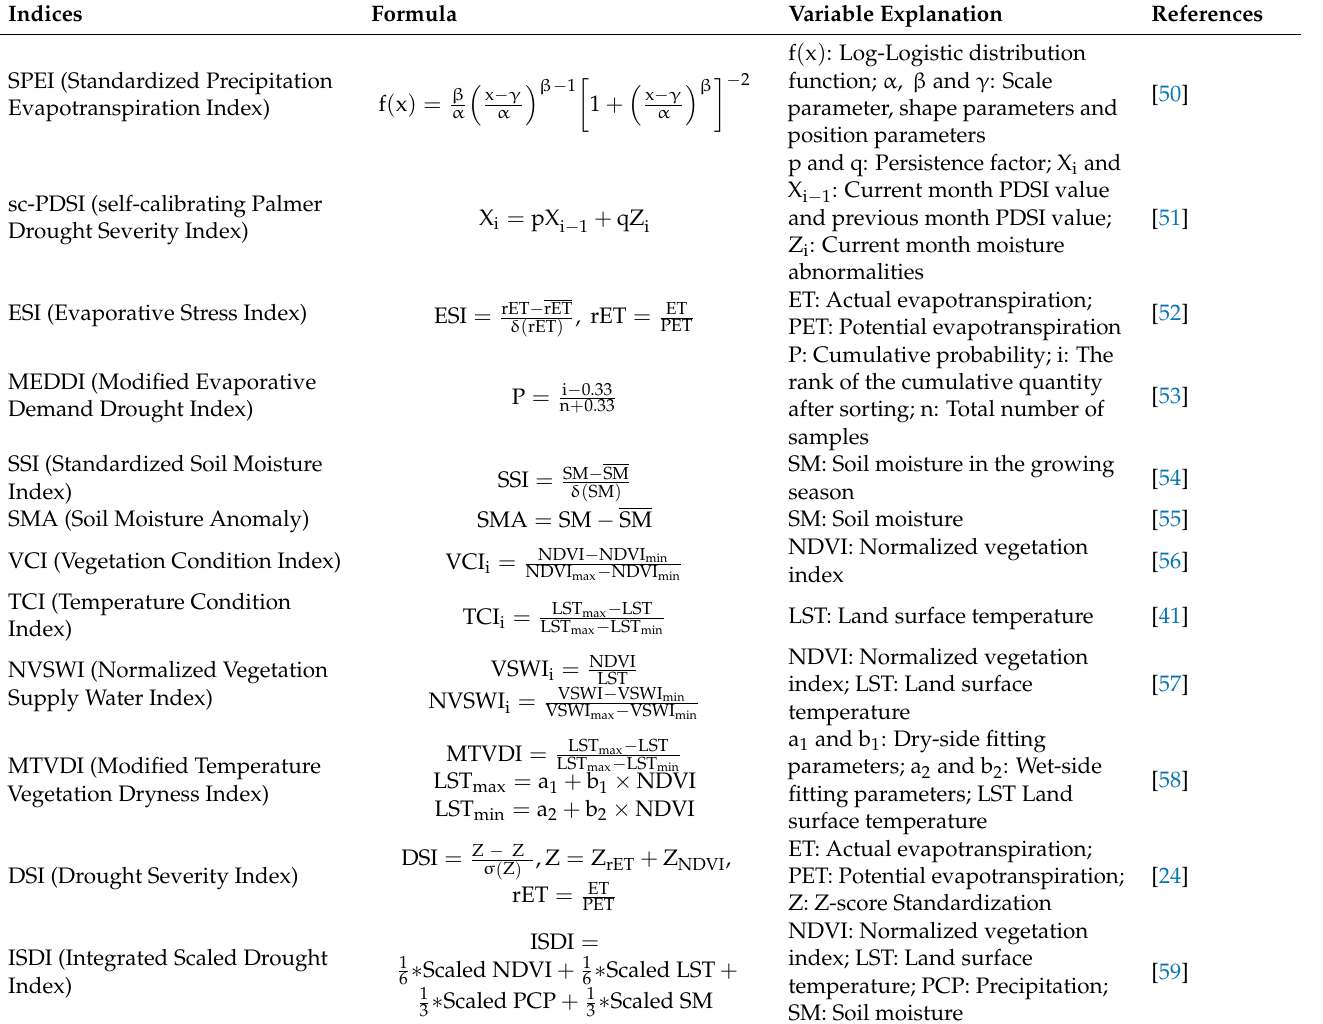
Table 2. The widely used drought